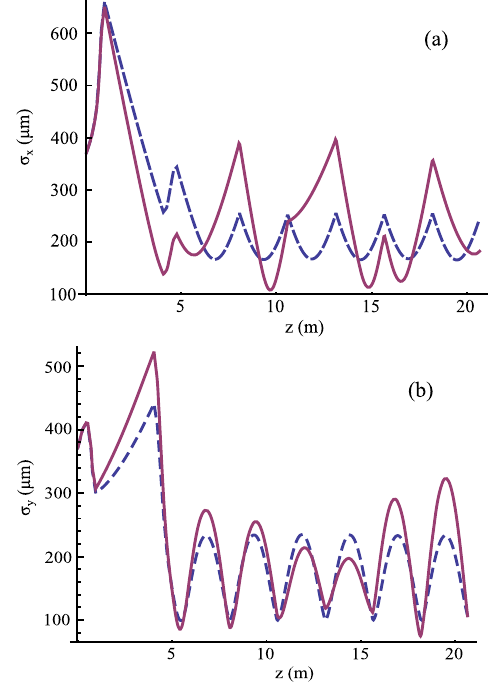
FIG. 2. Comparison between the matching (blue dashed line) and an alternative transport (red continuous line) condition for the e-beam from the linac exit to the end of the undulator with the beamparametersgiveninTableI.Thebehaviorofthetwotransverse beam sizes σ and σ is reported respectively in (a) and x y